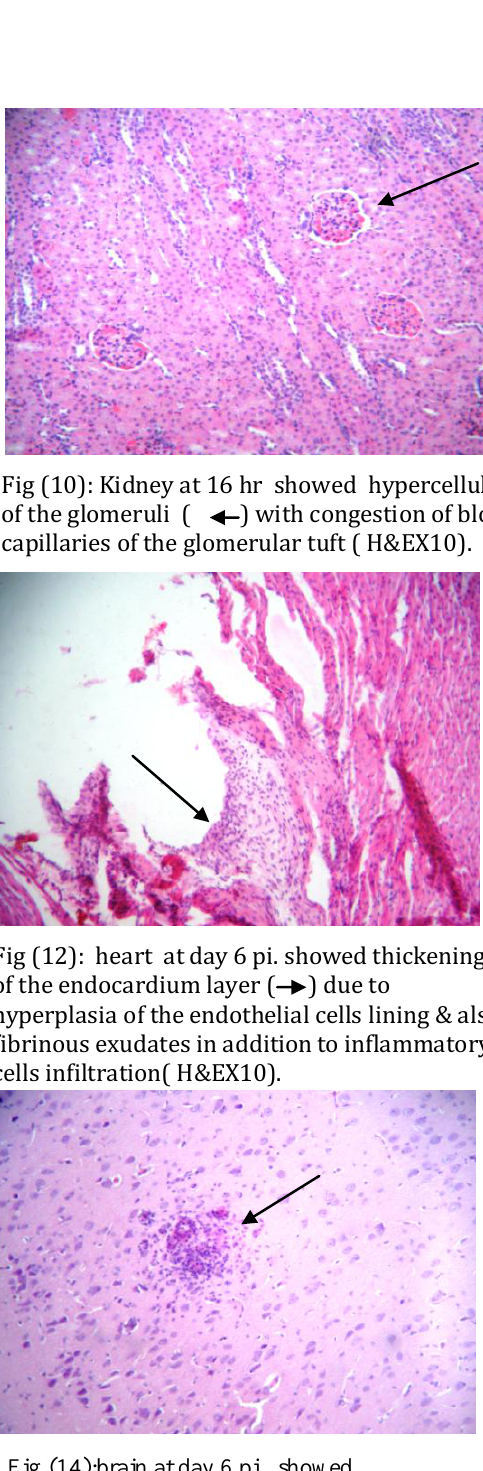
Fig (13): brain at day 2 pi. reveals lymphocytic infiltration in the meningies ( ) ( H&EX10).